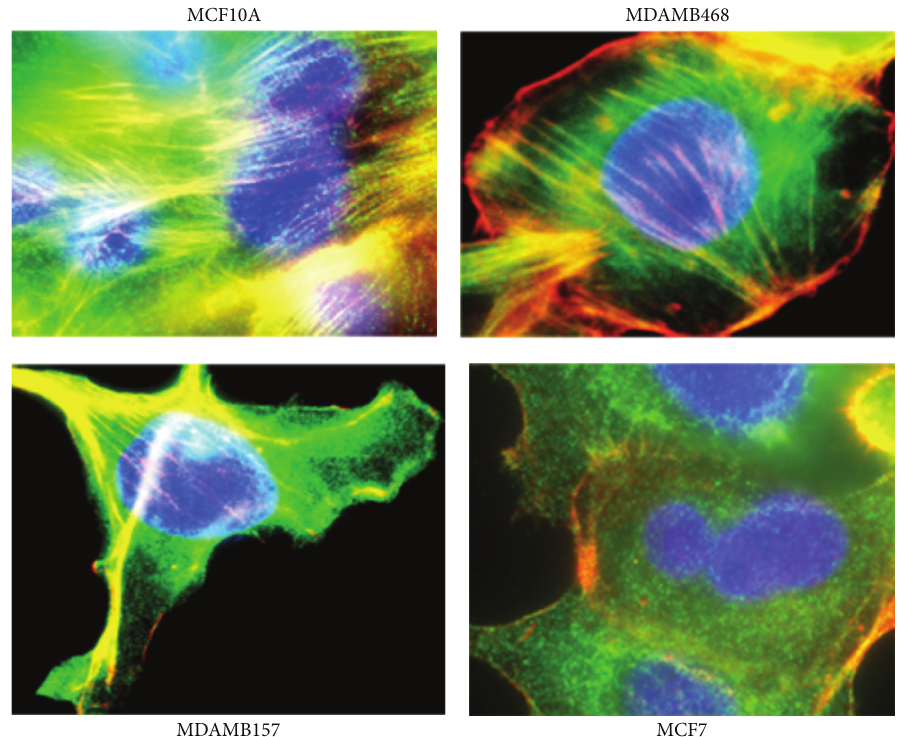
Figure 2: Merged photograph of one “normal” (MCF10A) and three malignant (MDAMB468, MDAMB157, and MCF7) human breast cell lines after staining with TM311, phalloidin, and DAPI. The stress fibers are the linear lines that contain both actin and tropomyosin resulting in a variety of colors depending on the background, while the nuclei are stained blue with DAPI. The cell lines were given the following stress fiber scores: MCF10A ++++, MDAMB468 +++, MDAMB157 ++, and MCF7